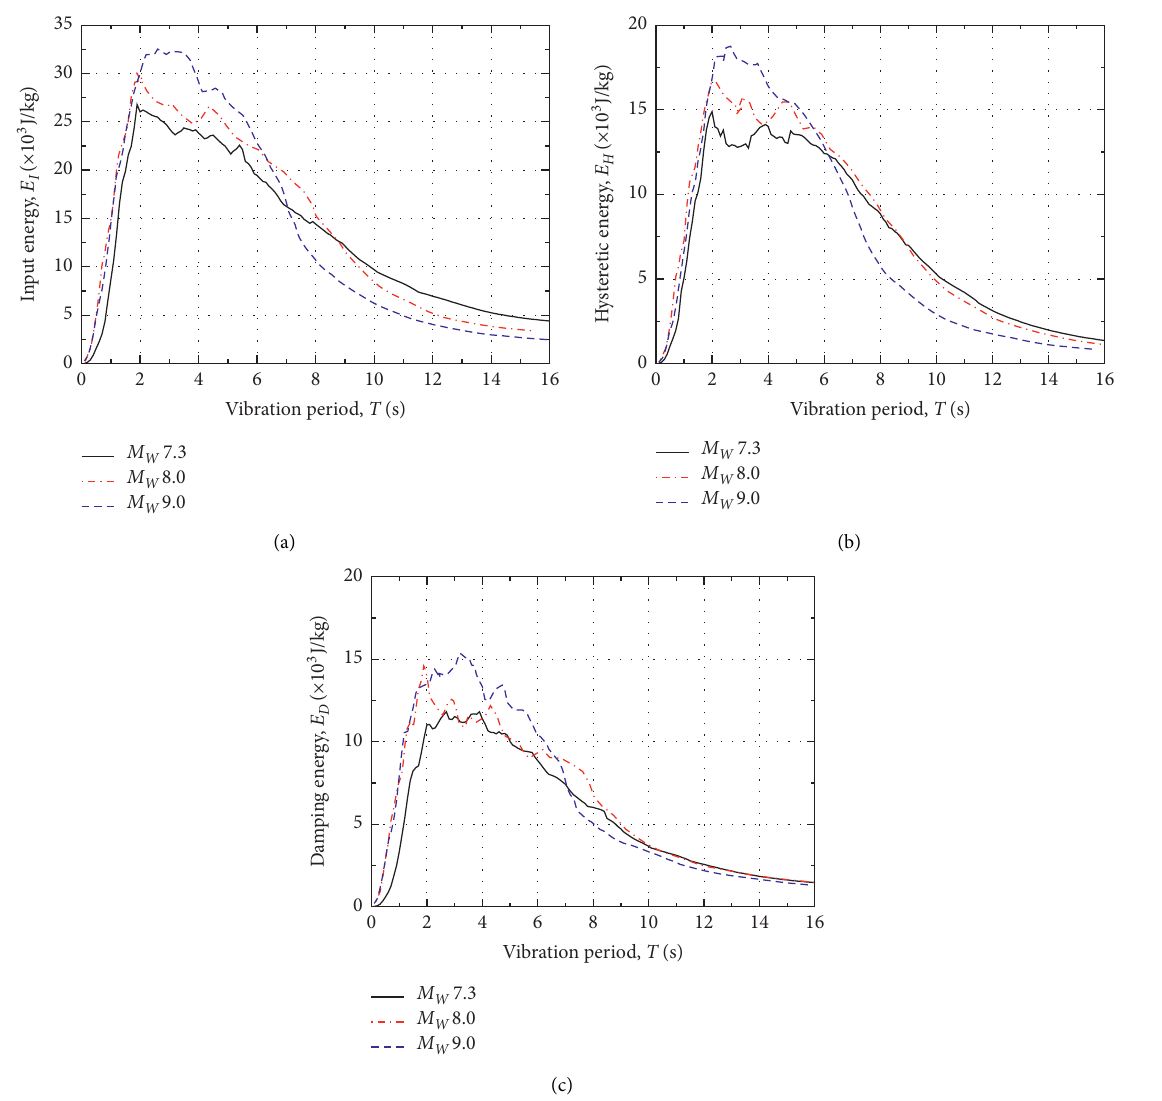
Figure 5: Energy response spectra affected by earthquake magnitude under far-field harmonic ground motions. (a) Input energy. (b) Hysteretic energy. (c) Damping energy.